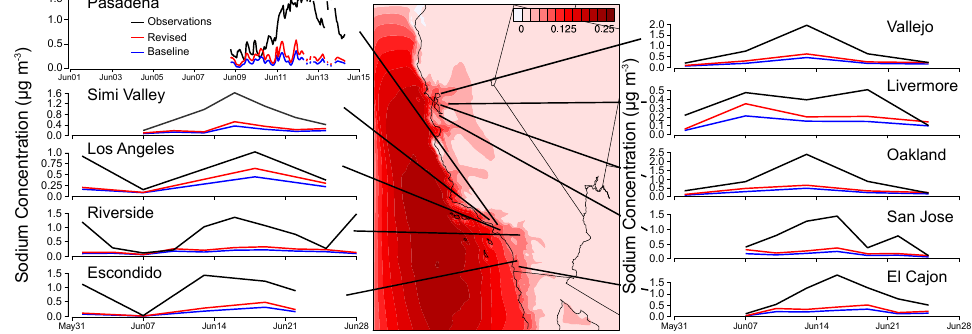
Figure 5. Change (µgm − 3 ) in the fine-mode (Aitken + accumulation) surface sodium concentration between the revised and baseline simulations for June 2010 over the CalNex domain surrounded by time series plots of the observed and predicted daily and/or hourly PM 2 . 5 - sodium concentration at the coastal CalNex sites.